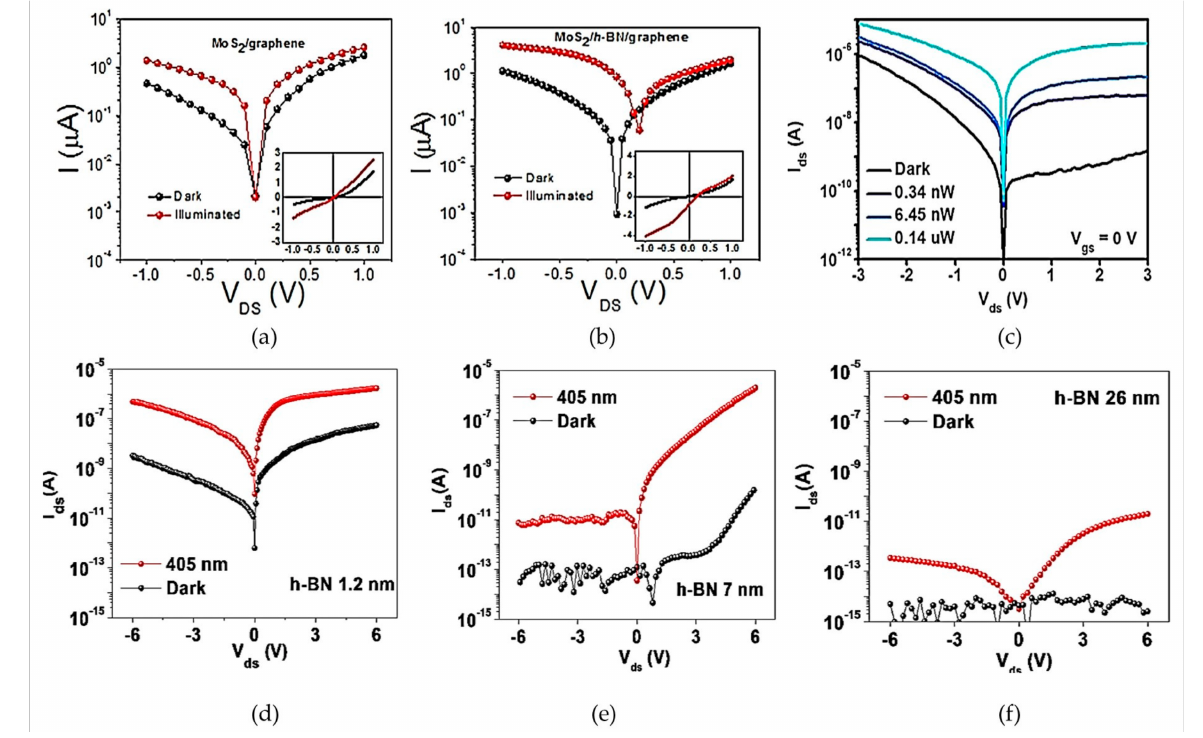
Figure 11. I–V characteristics of MoS 2 /h-BN/graphene photodetectors. Vertical MoS 2 /graphene photodetector ( a ) without and ( b ) with h-BN insertion (Reprinted from [10], with permission from Elsevier, 2019). ( c ) Lateral graphene/MoS 2 /graphene photodetector (Reprinted with permission from [19], American Chemical Society, 2020). MoS 2 /h-BN/graphene photodetec- tor with varied thickness of h-BN at ( d ) 1.2 nm, ( e ) 7 nm and ( f ) 26 nm (Reprinted with permission from [47], American Chemical Society,